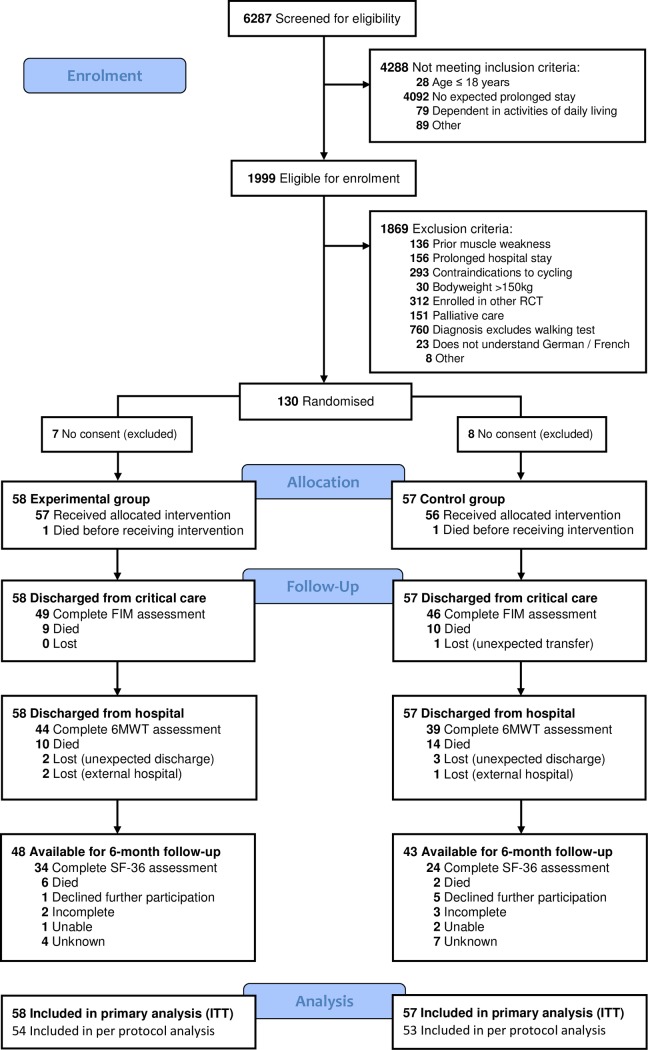
Study flow diagram (CONSORT).